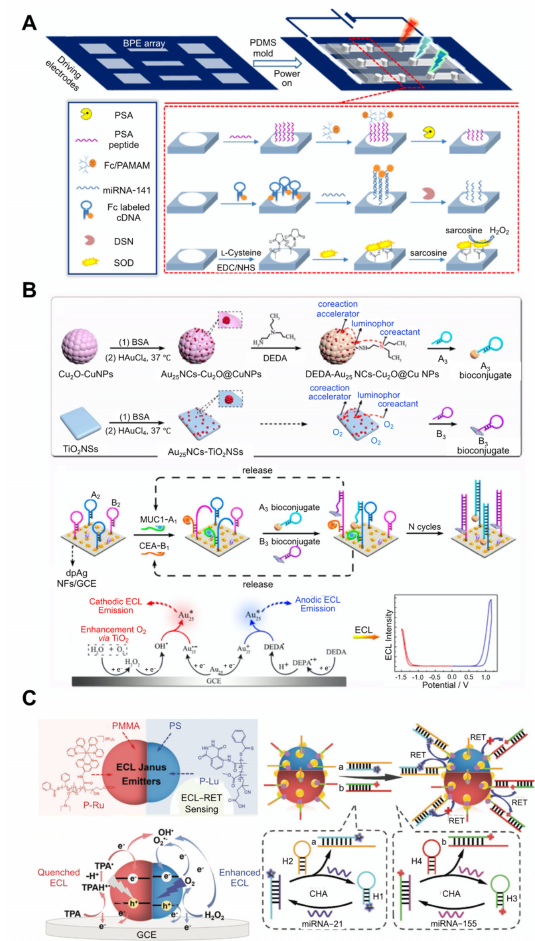
Figure 3. An ECL-based sensing strategy and technology for the detection of multiple